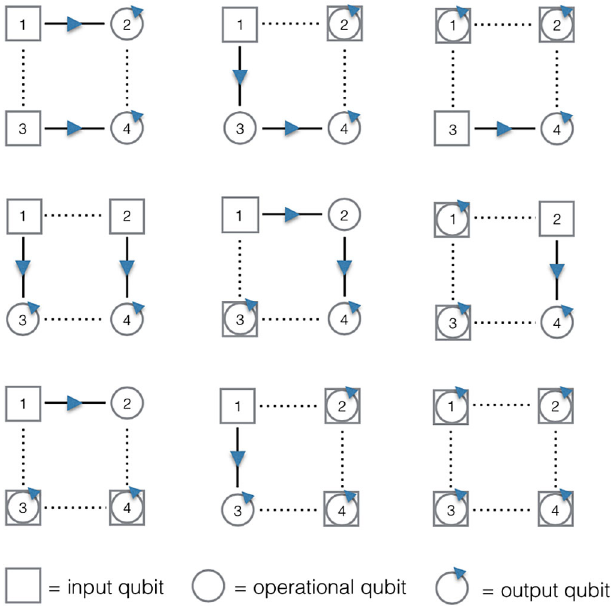
FIG. 5. List of the nine possible G ð I; O Þ 2 (and associated patterns) with g-flow for the cluster state . The arrows indicate the direction of the quantum j CS i 2 ; 2 information flow. Note that overlapping input and output sets are allowed. All the patterns implement unitary embeddings on the input